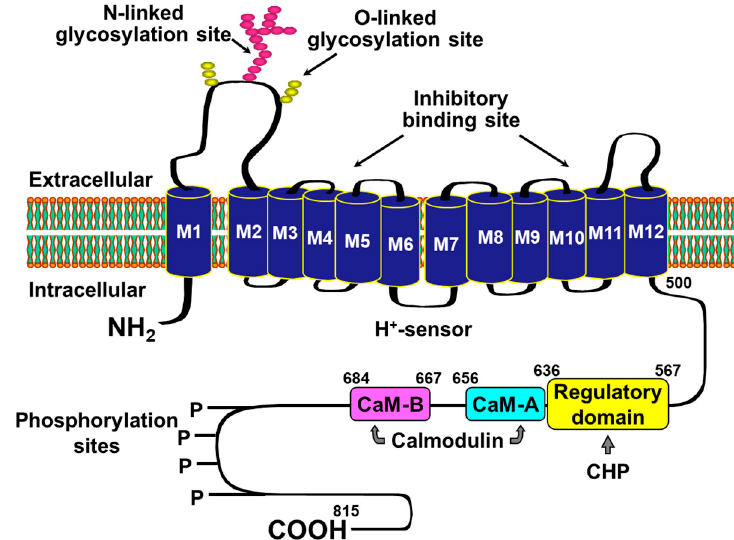
Figure 1. Putative topologic model of an 815-amino acid Na + -H + exchanger isoform-1. Depicted are 12 transmembrane-spanning segments and a 315-amino acid cytoplasmic hydrophilic carboxyl terminus domain (COOH). The transmembrane domain includes the intracellular H + -sensor site, the functional ion exchange site, and the site where inhibitors bind. The cytoplasmic domain includes sites for regulation via phosphorylation-dependent (P) and phosphorylation-independent mechanisms. Depicted are CaM-A and CaM-B representing high- and low-a ffi nity binding sites for the Ca 2 + binding protein calmodulin and CHP, denoting calcineurin homologous protein. Not shown are additional regulatory sites in the cytoplasmic domain for the extracellular signal regulated kinase (ERK1 / 2), p38 mitogen-activated protein kinase (MAPK), ribosomal S6 kinase (RSK), RhoA kinase, and the tyrosine kinase 2 (Pyk2).